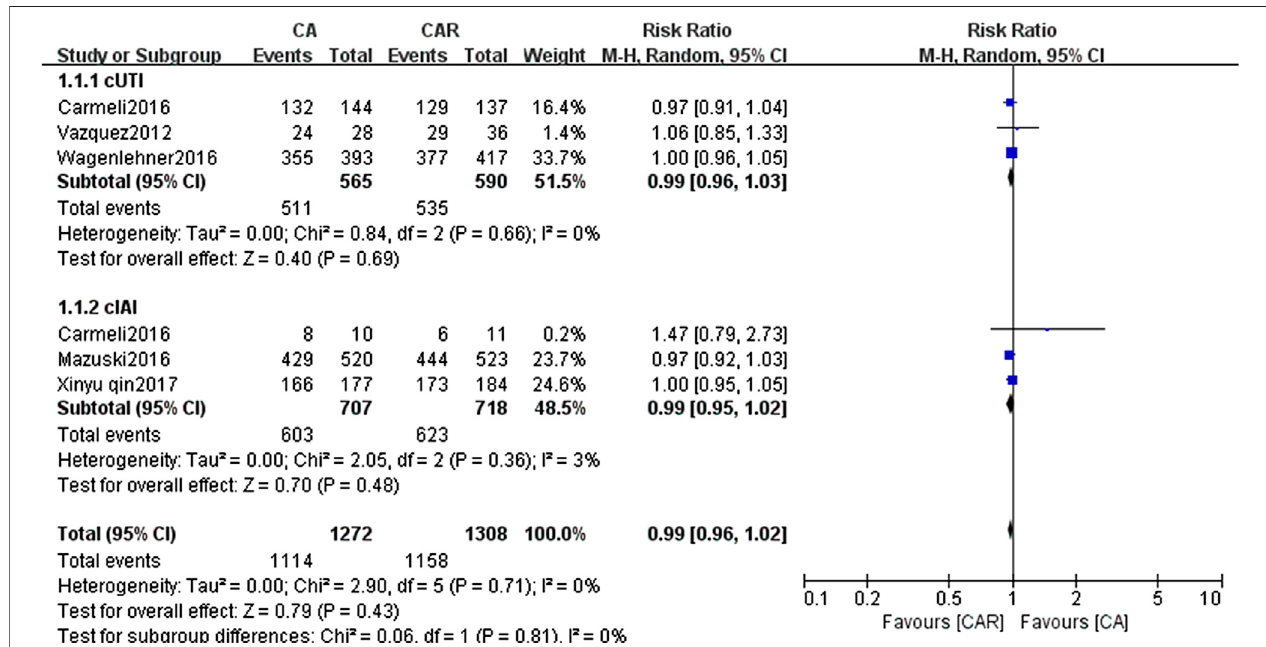
FIGURE3| Forestplotsshowingrelativeriskwith95%con fi denceintervalofclinicalsuccessinarandom-effectsmodel.cUTI,complexurinarytractinfection;cIAI, complicated intra-abdominal infection; CA, ceftazidime/avibactam; CAR, carbapenems.